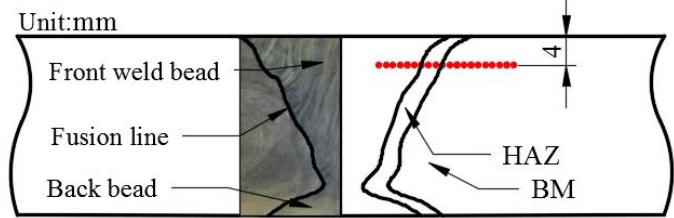
Figure 4. Sampling diagram of hardness test point of welded joint .